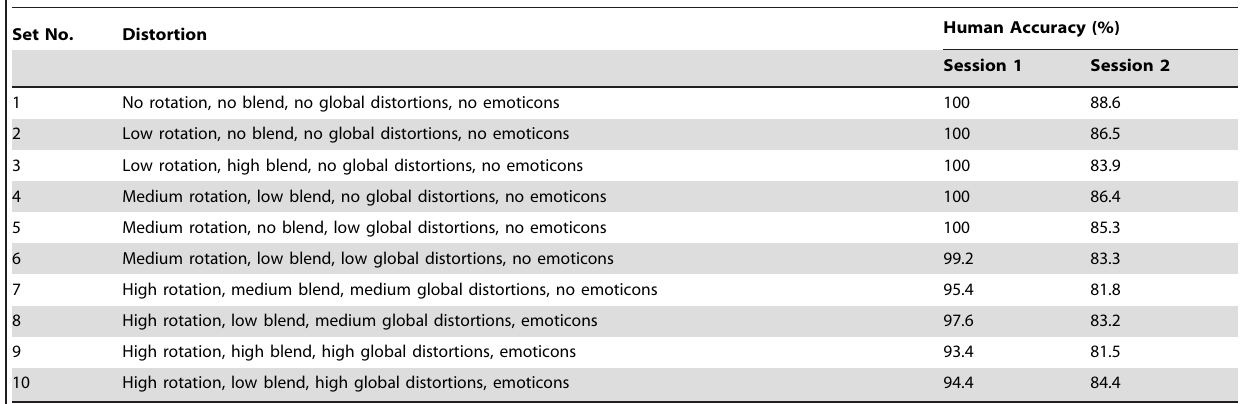
Table 3. Human performance for each set of CAPTCHAs.